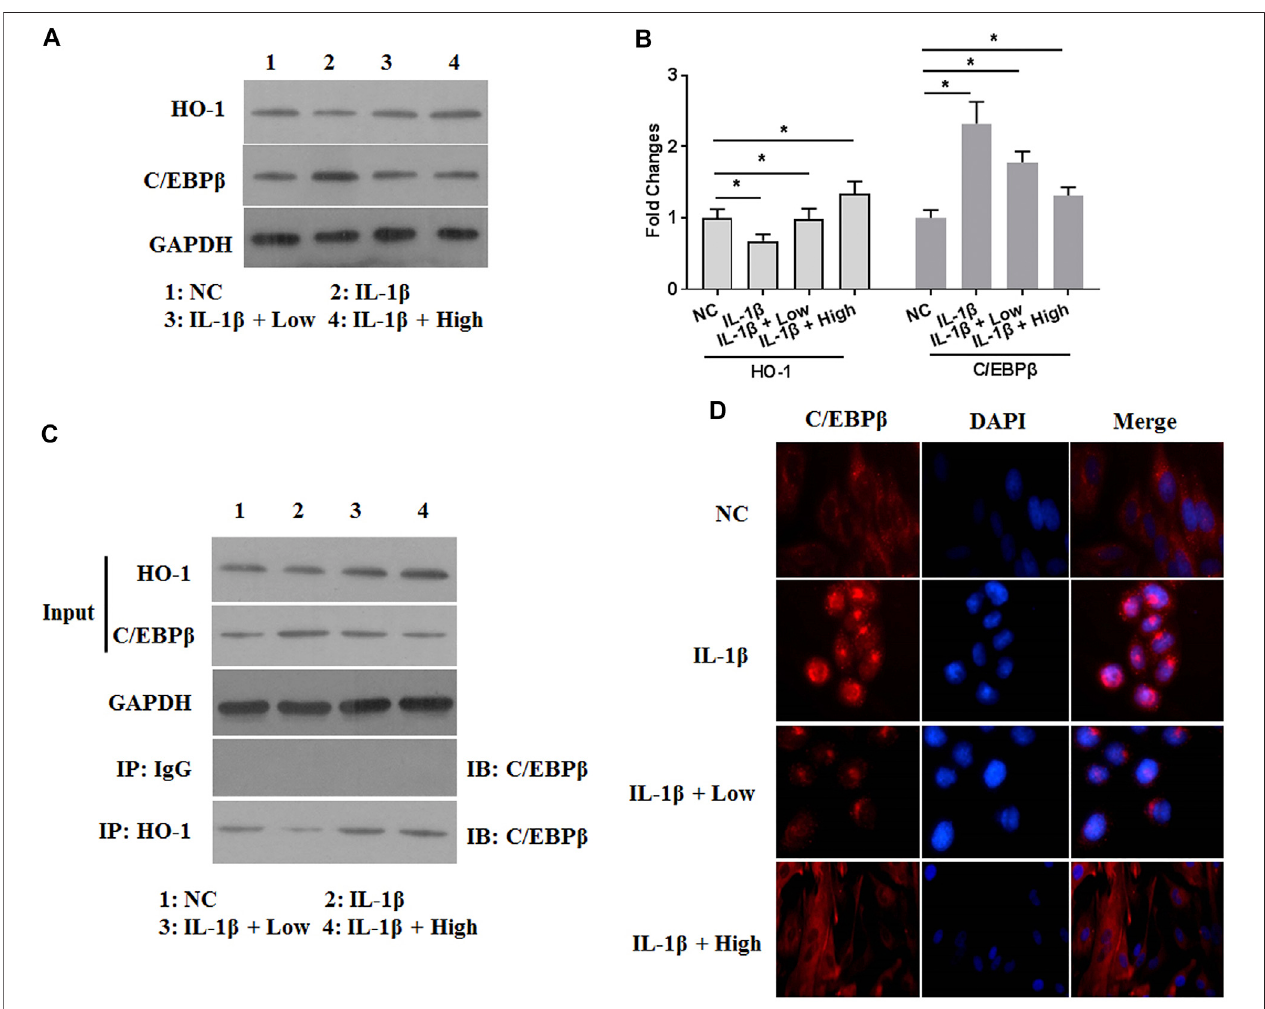
FIGURE 5 | XH increased the expression of HO-1 and attenuated the expression of C/EBP β in IL-1 β -treated chondrocytes. (A) The proteins expression of HO-1 and C/EBP β were detected by western blotting. (B) The quanti fi ed values of tested proteins were indicated. (C) The co-immunoprecipitation of HO-1 and C/EBP β was studied. (D) Theimmuno fl uorescencestudyofC/EBP β inIL-1 β -treatedchondrocytes.Allexperimentswereperformedintriplicateanddataarepresentedasthemean ± standard deviation. * p < 0.05 and ** p < 0.01. NC, negative control; Low, XH (5 μ M); High, XH (20 μ